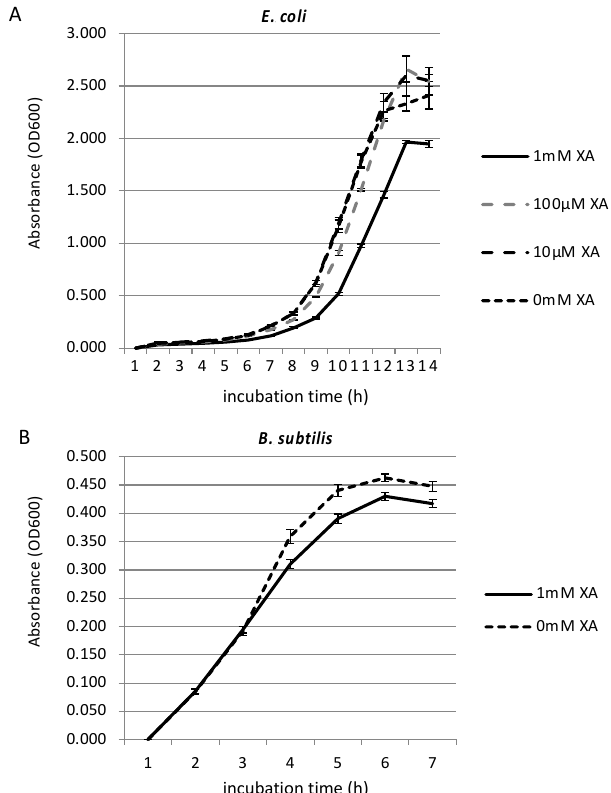
Figure 2. Growth inhibition effect of xanthurenic acid. Growth curves of E. coli ( A ) and B. subtilis ( B ) in LB medium with different concentrations of xanthurenic acid (XA). In both species, 1 mM xanthurenic acid has significant inhibitory effects (Welch t -test p < 0.05).